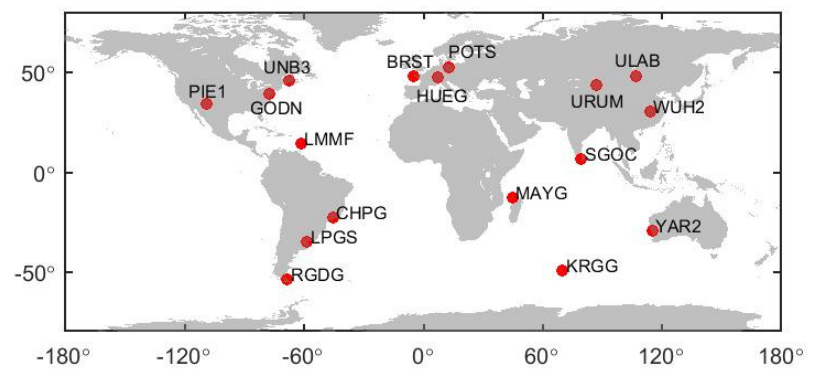
Figure 1. Monitoring station distribution. Table 1. Precise point positioning configuration parameters.